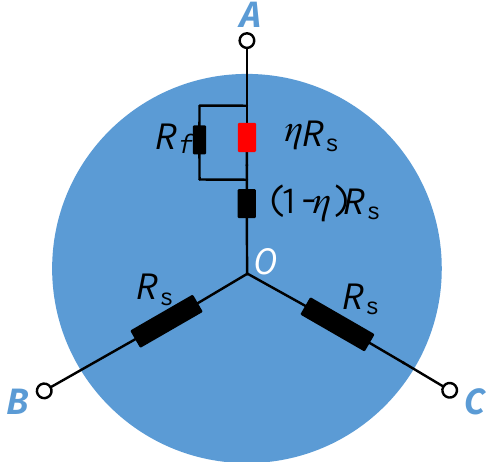
Figure 3. DC equivalent circuit when the motor has stator fault.